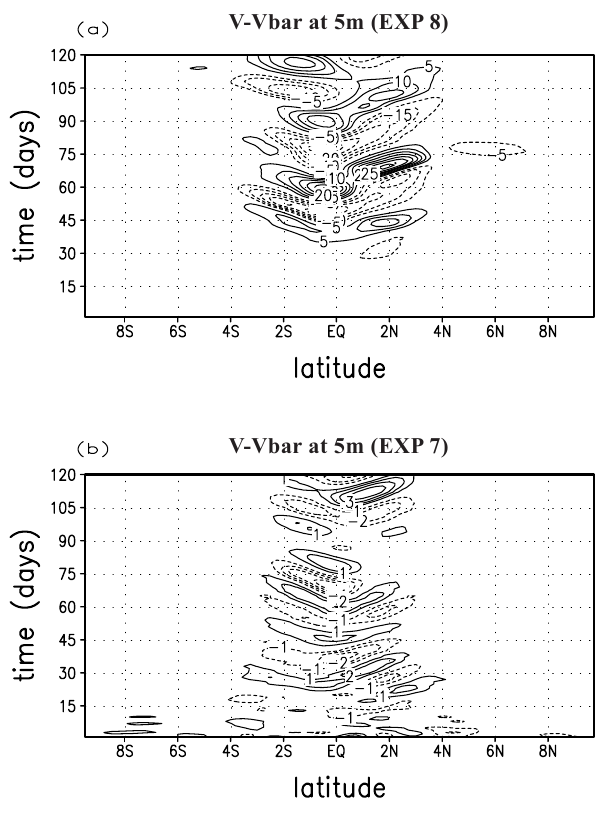
Fig. 5. Time-latitude diagrams of perturbation meridional velocity at 5m for: (a) EXP 8 and (b) EXP 7. Contour interval is 5cm/s in (a) and 1cm/s in